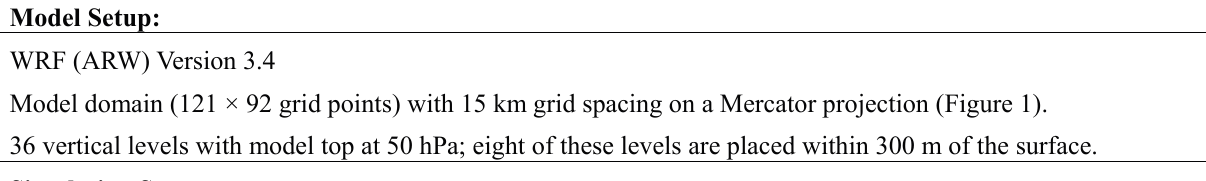
Table 4. Summary of model and system setup and physical parameterizations used in the control WRF